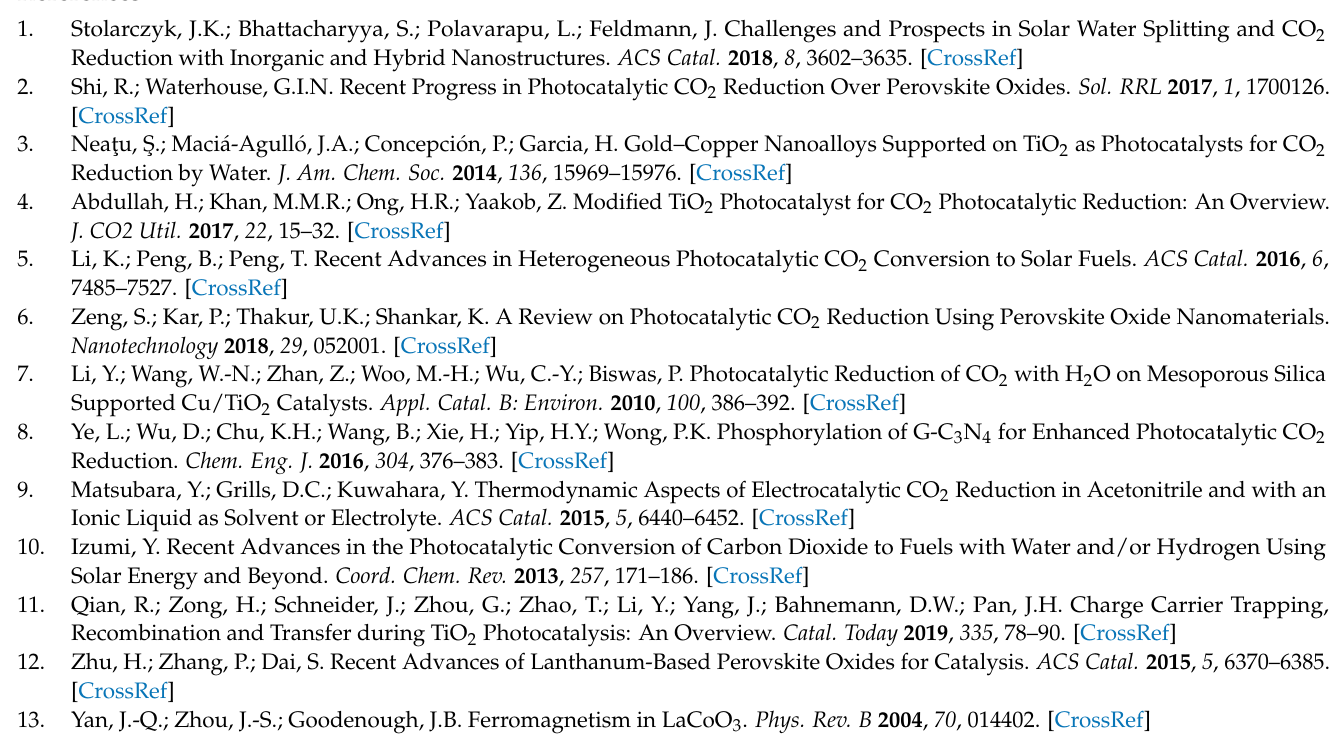
Table S2: The Eg, CB, VB and CH 4 yield of LCMO, LMNO and LNCO (x = 0, 0.2, 0.4, 0.6, 0.8 and 1.0); Figure S6: Mott–Schottky plots of LaNi 0.4 Mn 0.6 O 3 , LaCo 0.6 Mn 0.4 O 3 and LaNi 0.6 Co 0.4 O 3 ; Figure S7: The XPS spectra of (a) Co 2p, (b) Ni 2p, (c) Mn 2p (d) and O 1s of LCMO and LMNO; Figure S8: Two exponential decay function and fitting curve of LaCo 0.6 Mn 0.4 O 3 ; Figure S9: The error of lifetime of LCMO, LMNO and